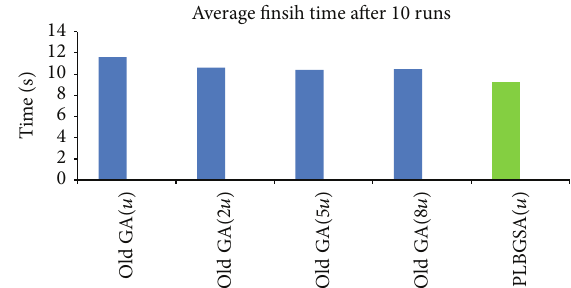
Figure12:Comparisonofaveragefinishtimefortask 𝑡 usingoldGA with u, 2u, 5u, and 8u generations and PLBGSA with 𝑢 generations.